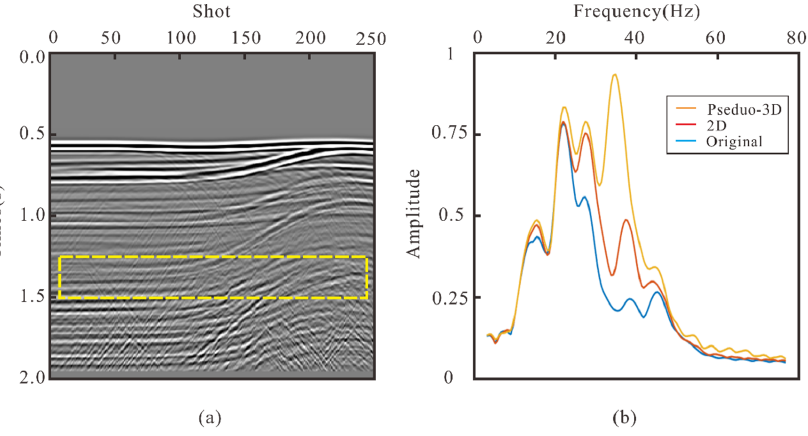
Figure 9. Frequency comparison of the different methods. ( a ) COG. ( b ) Frequency spectrum.